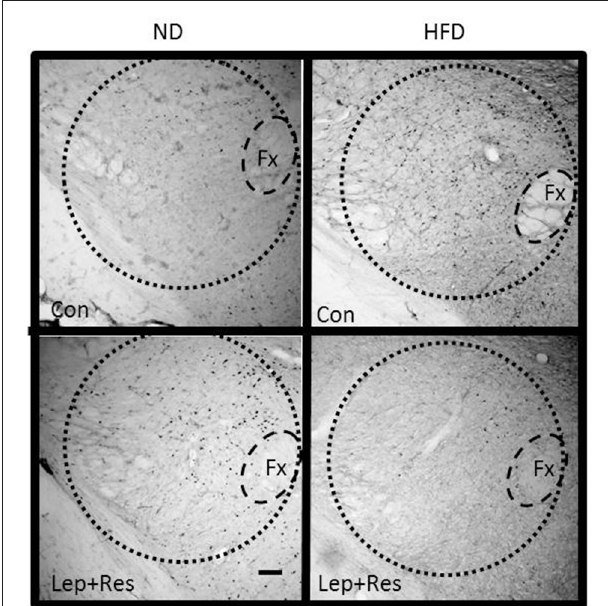
FIGURE 11 | Photomicrographs showing Fos-positive cell nuclei in the lateral hypothalamic area (outlined by dashed lines) of rats fed a high fat diet (HFD) and rats fed a normal diet (ND) following centrally administered saline (5 µ l; control) or leptin combined with resistin (7 µ g). Fx, Fornix. Scale bar = 100 µ m. The rostrocaudal levels of the sections counted were at ∼ 1.8–2.0mm caudal of bregma.